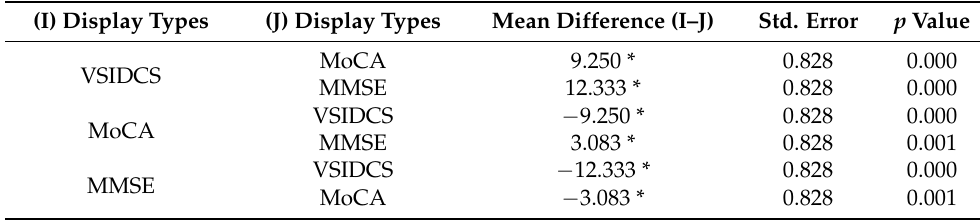
Table 5. Tukey’s post hoc tests for the effects of VSIDCS, MoCA, and MMSE on involvement.